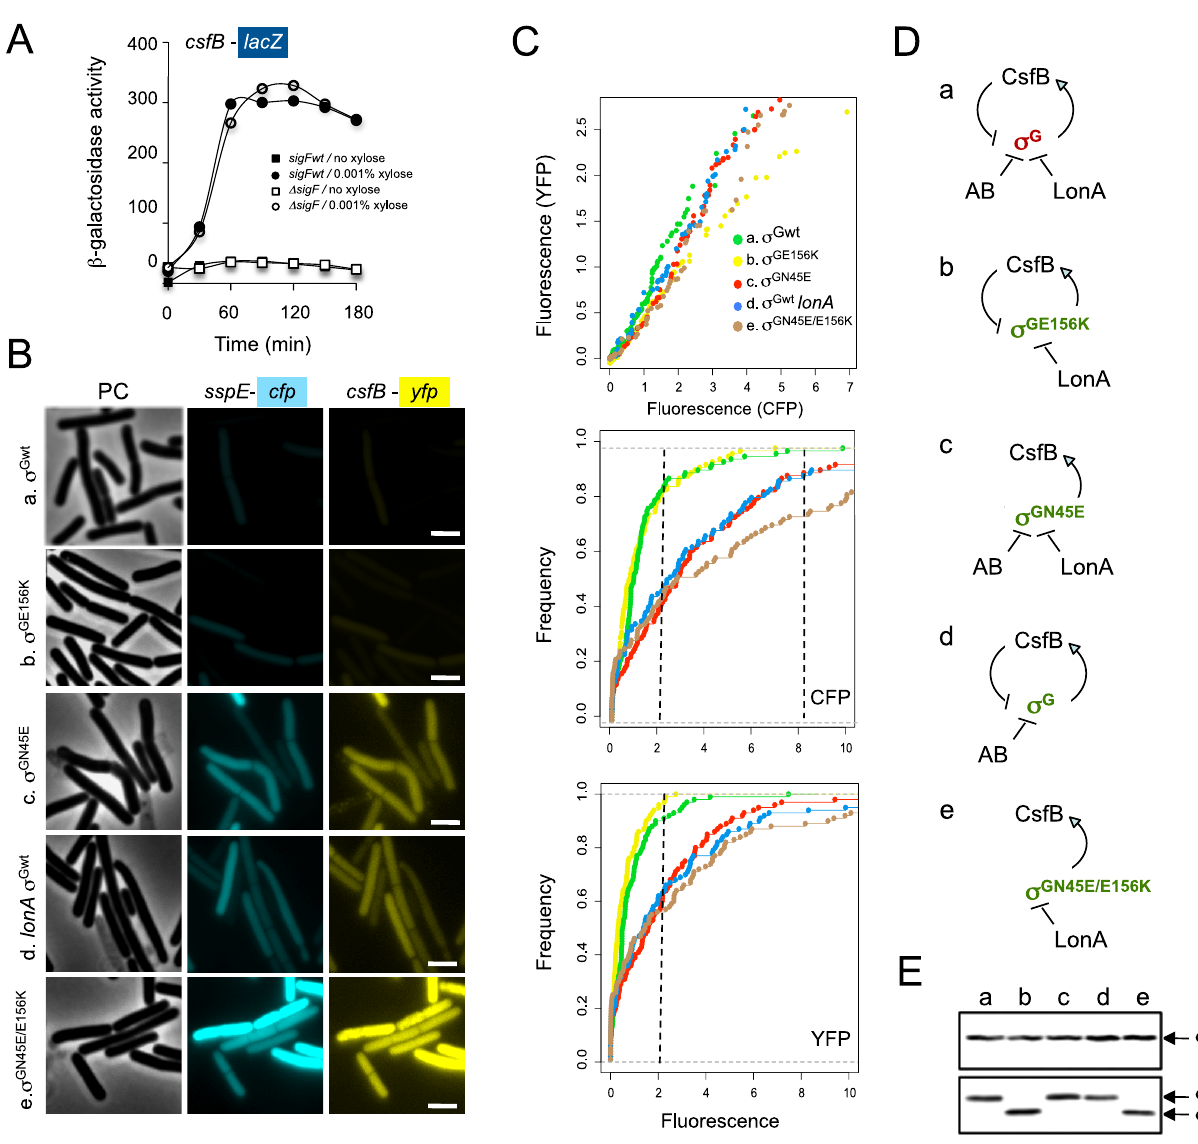
Figure 5. s G drives expression of csfB under non-sporulation conditions. Panel A: Strains carrying a P csfB - lacZ fusion, a xylose-inducible P xylA - sigG construct and the wild type sigF gene or a D sigF deletion, were grown to mid-log phase in LB medium and induced (circles) or not (squares) with 0.001% xylose. Samples were collected at the indicated time intervals and assayed for b -galactosidase activity (shown in Miller units). Panel B, s G activity and csfB expression was monitored in the same cells, by fluorescence microscopy, at the onset of stationary phase in LB. The strains used carry P sspE - cfp and P csfB - yfp reporter fusions, a deletion of the sigG gene, and a copy of the wild type sigG gene (a), sigGN45E (b), sigGE156K (c), wild type sigG in a lonA deletion mutant (d), or sigGN45E / E156K (e) at the amyE locus under the control of P xylA . The strains were grown in the presence of 0.001% xylose. Scale bar, 2 m m. Panel C: quantitative analysis of CFP and YFP expression for the strains (a to e) examined in B. The top plot shows the correlation between the YFP ( csfB-yfp ) and CFP (P sspE -cfp ) signals. The middle and bottom graphs show a cumulative frequency distribution of the YFP and CFP signals across the population. Fluorescence intensity is shown in arbitrary units; 100 cells were scored. Panel D shows the schematic representation of the regulatory interactions in the experimental situations shown in panels A and B (inactive and active s G in brown and green, respectively). Panel E: immunoblot analysis of s G accumulation in the strains (a-e) defined in panel B. Strains were grown in LB medium and samples taken at the onset of the stationary phase for microscopy or immunoblot analysis. ‘‘ s G ’’ represents the position of the wild type protein or s GN45E . The asterisk denotes s GE156K or s GN45E/E156K , both of which, because of the E156K substitution, migrate slightly faster than the wild type or s GN45E proteins